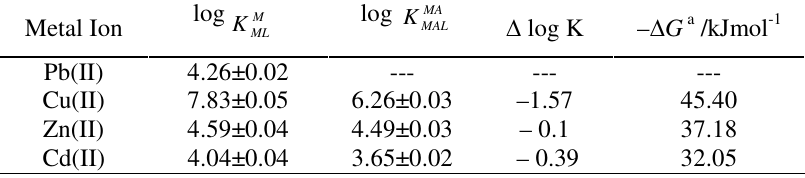
Table 6 . Stability constants of 1:1:1 ternary complexes involving Metal